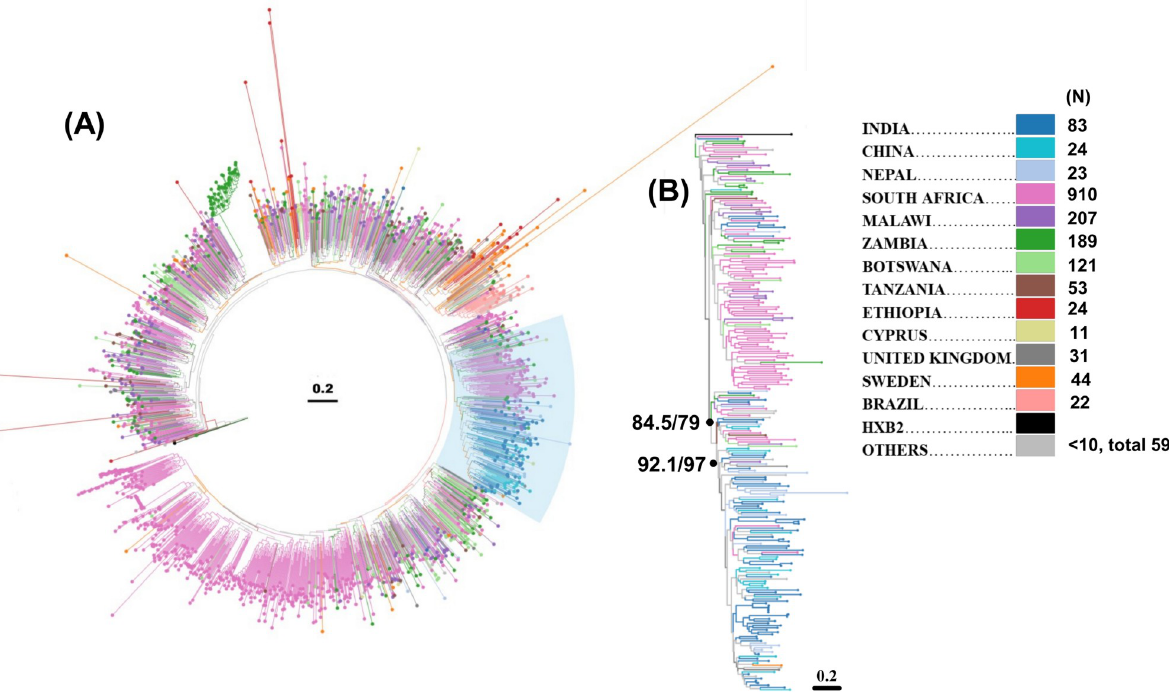
Fig 1. Phylogenetic Analysis of HIV-1 subtype C gp120 amino acid sequence. A. A maximum likelihood tree depicting phylogenetic association of 1837 HIV-1 subtype C amino acid sequences depicted radially. The legend describes the country codes as well as the sequence distribution among the countries. B. A maximum likelihood subtree detailing phylogenetic association between sequences from South Africa and Those from India, China and Nepal. The black dots indicate nodes with corresponding SH-aLRT and bootstrap values.